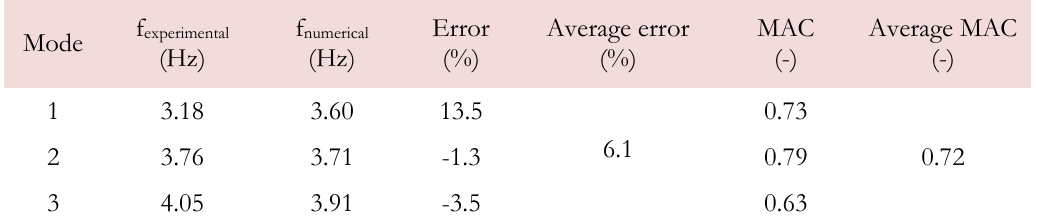
Table 6: Comparison between numerical and experimental frequencies f and mode shapes for the updated values of the elasticity modulus of masonry materials.